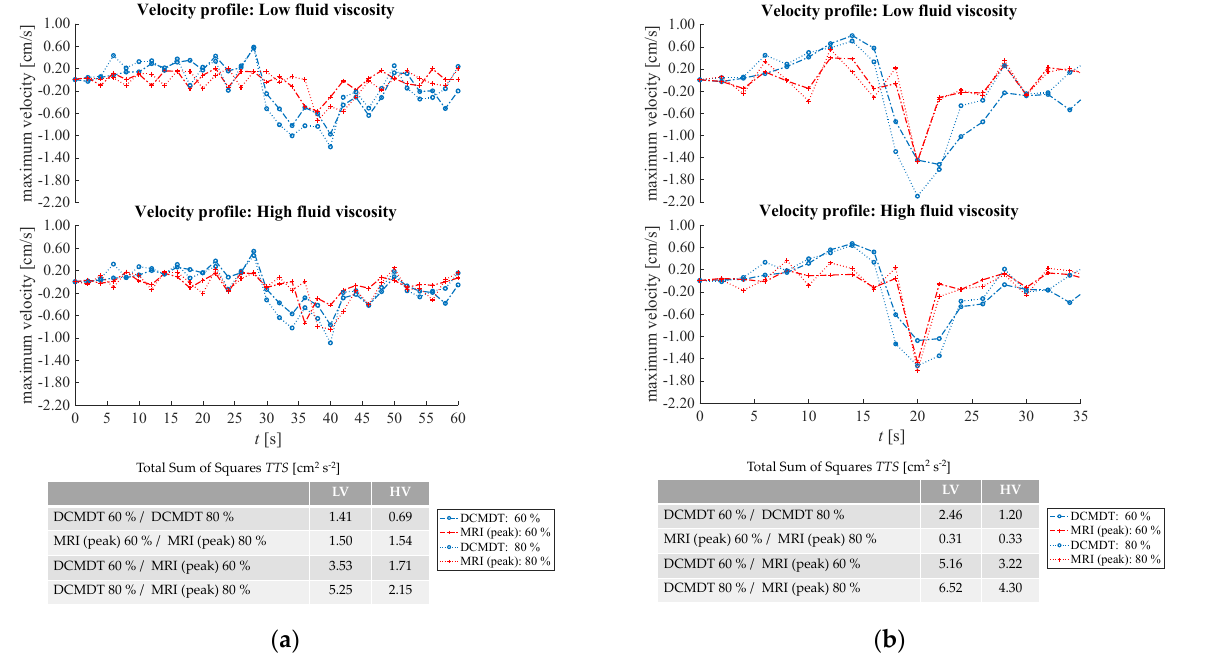
Figure 12. Comparison of the fluid velocities at different fluid volumes and different fluid viscosities of segment 6. ( a ) represents data for the slower propagating PPW and ( b ) for the faster propagating PPW ( b ). In the table for the Total Sum of Squares, the following abbreviations are used: LV—low viscosity, HV—high viscosity.